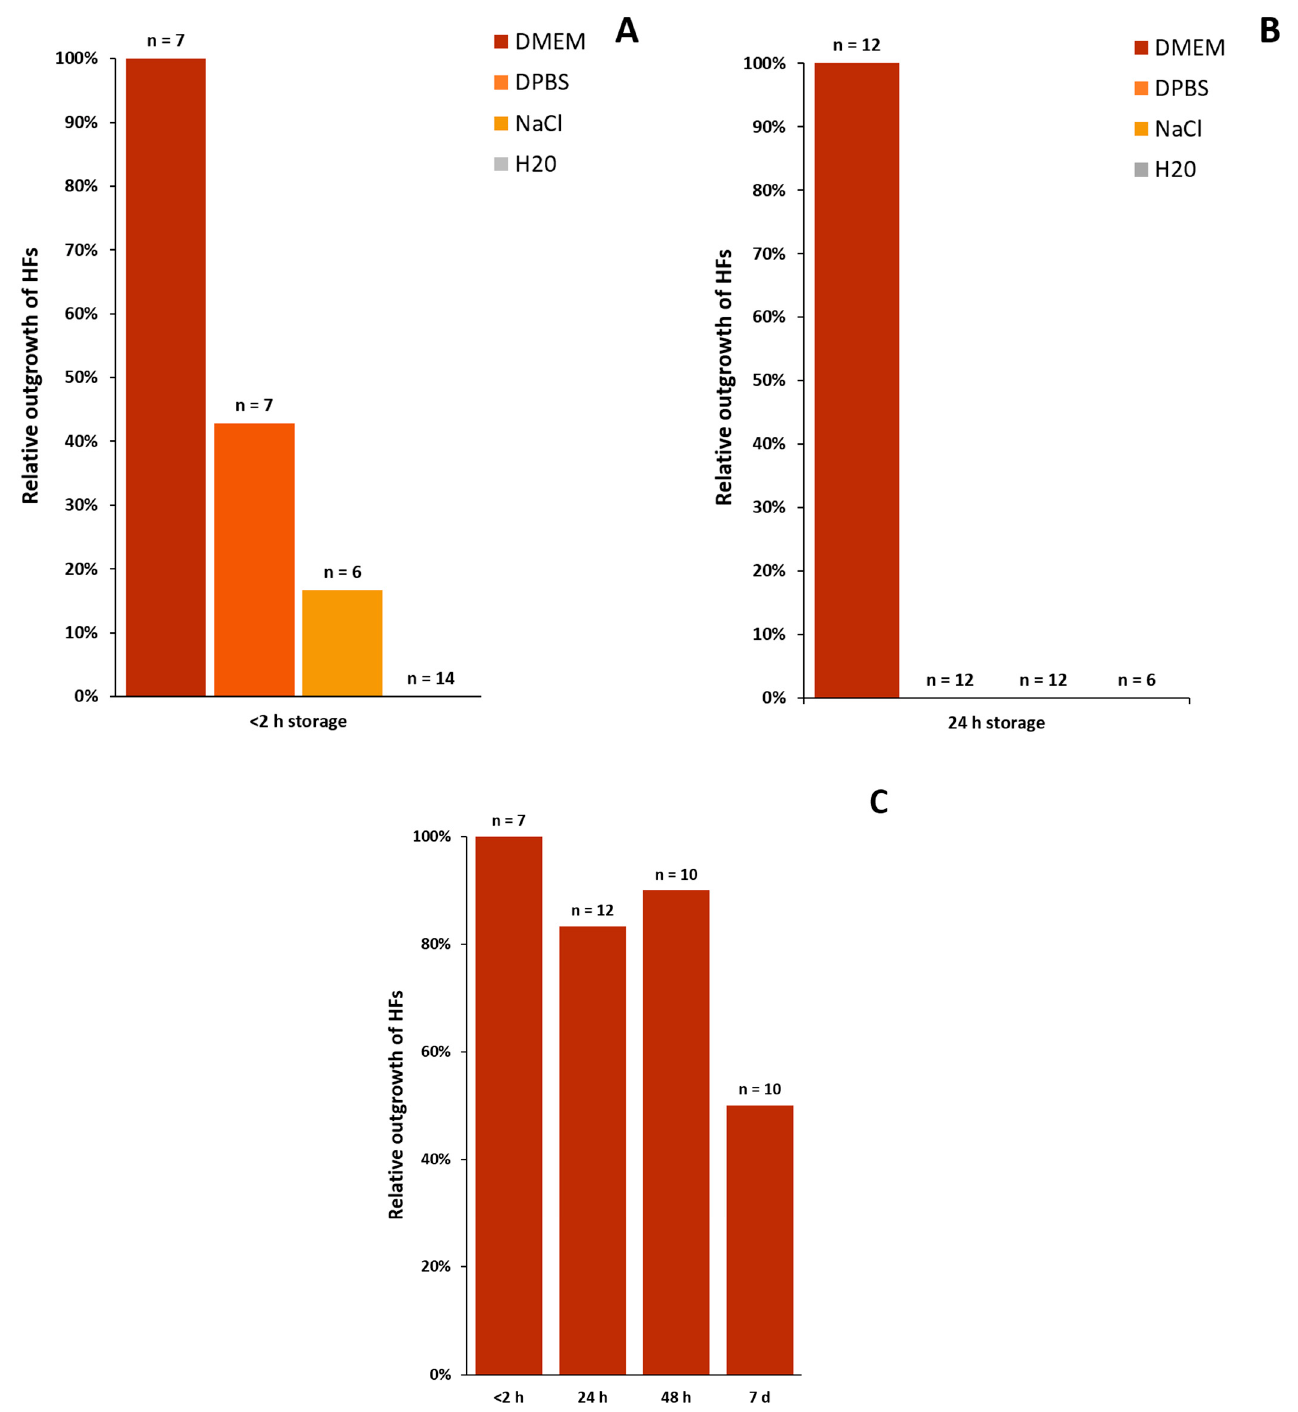
Figure 3. Outgrowth of HFs with respect to different transportation and storage conditions. ( A ) Relative outgrowth of keratinocytes from HFs after storage for a maximum of 2 h in either DMEM, DPBS − / − , NaCl or water (H 2 O). ( B ) Outgrowth after 24 h in the same four tested media. Keratinocytes stored in DMEM show the highest outgrowth rate. ( C ) Outgrowth of keratinocytes from HFs in percentanges after being stored in DMEM for a maximum of 2 h, 24 h, 48 h or 7 days (d). N = number of single, independent